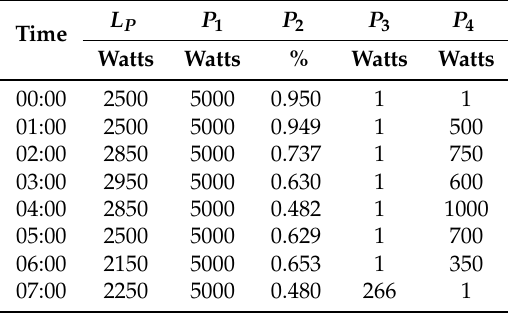
Table 3. Starting conditions (in Watts and percentages) of the resources included in the IMG. L P =